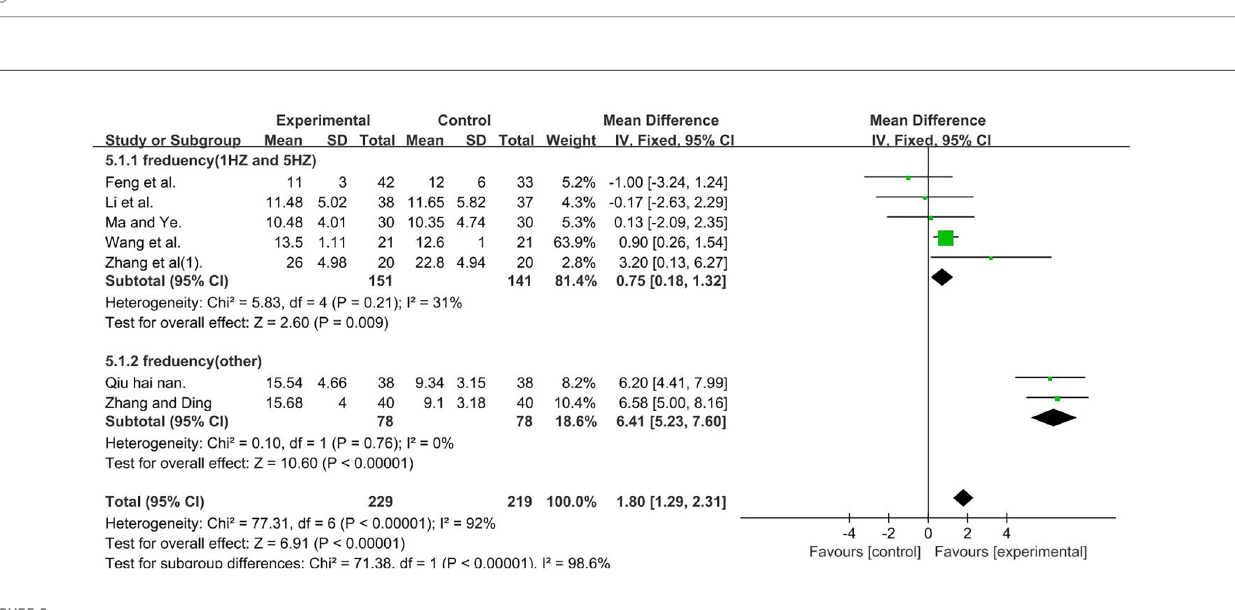
FIGURE 8 Forest plot showing MD (with 95% CI) for GMFM-E of the included studies comparing the experimental and control groups. Note: For the subgroup with frequencies of 1 and 5 Hz, P =0.21 and I 2 =31%. fi xed-effect model [MD=0.75, 95% CI (0.18, 1.32); P <0.05]. For the subgroup with frequency (other), P =0.76 and I 2 =0%, fi xed-effect model [MD=6.41; 95% CI (5.23, 7.60); P <0.001]. The analysis results of the two subgroups were statistically signi fi